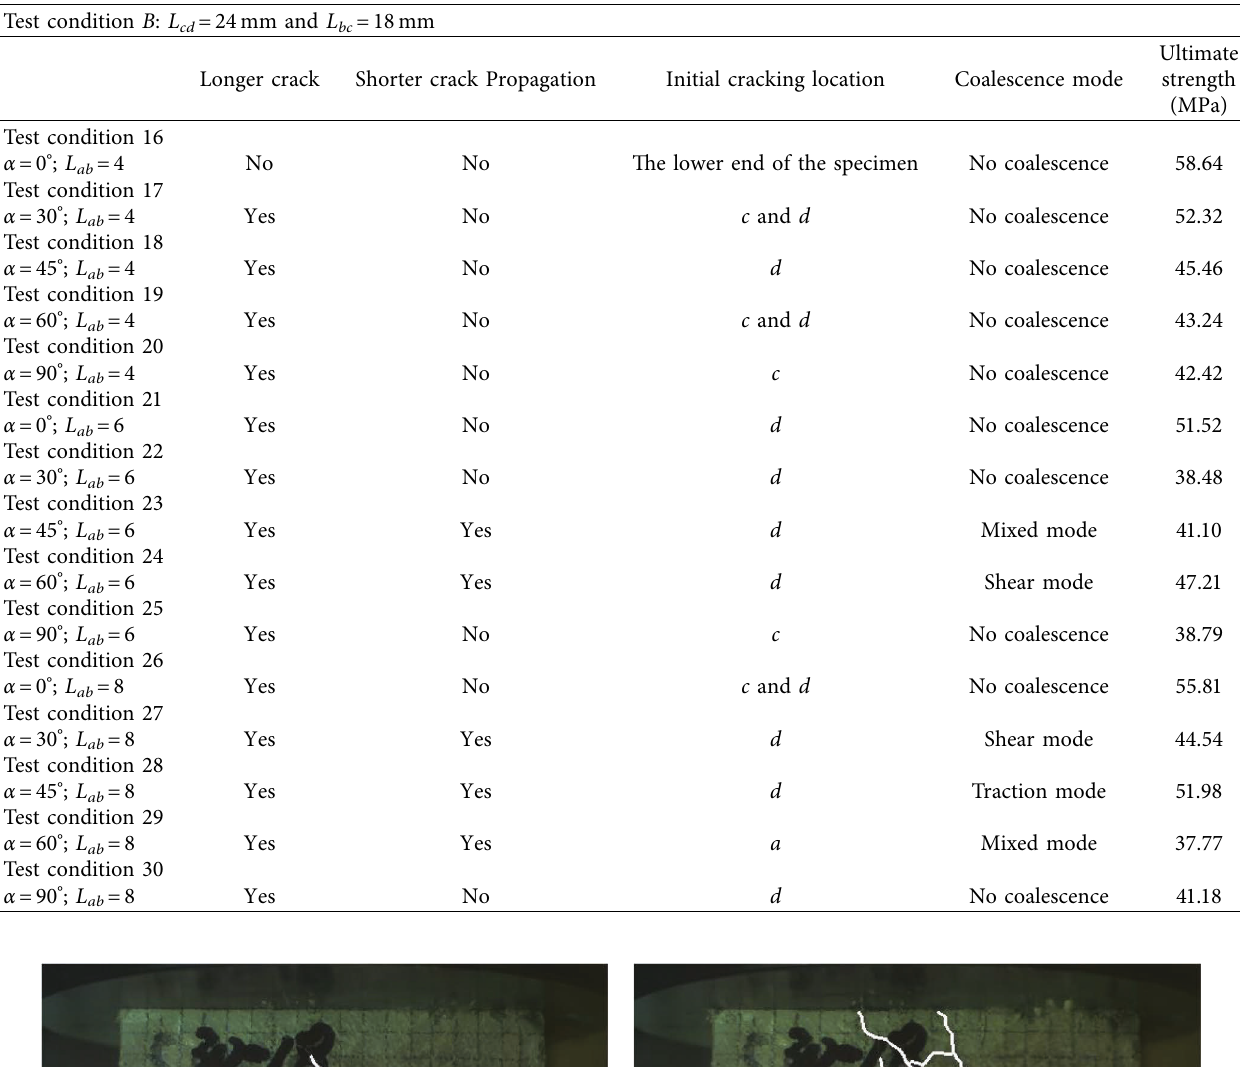
Table 5: The statistical table of the test condition B coalescence mode.